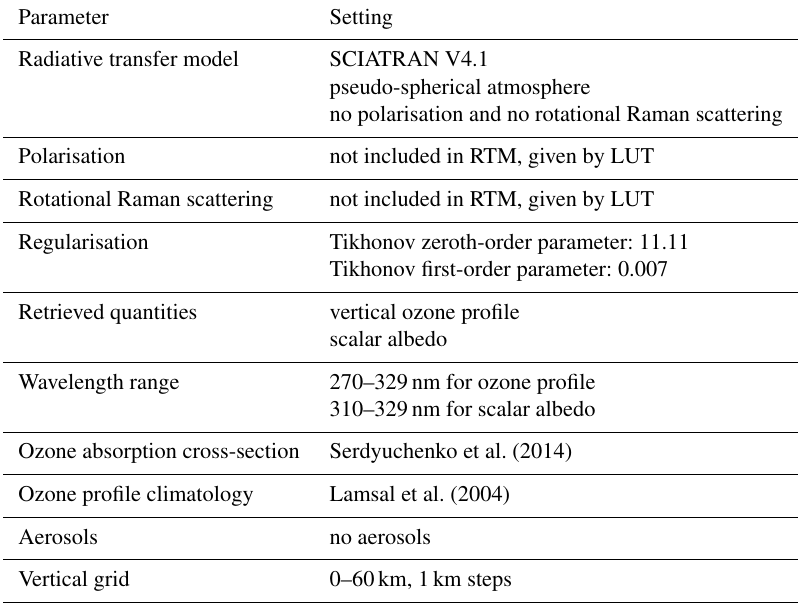
Table 1. Overview of the ozone profile retrieval settings. Parameter